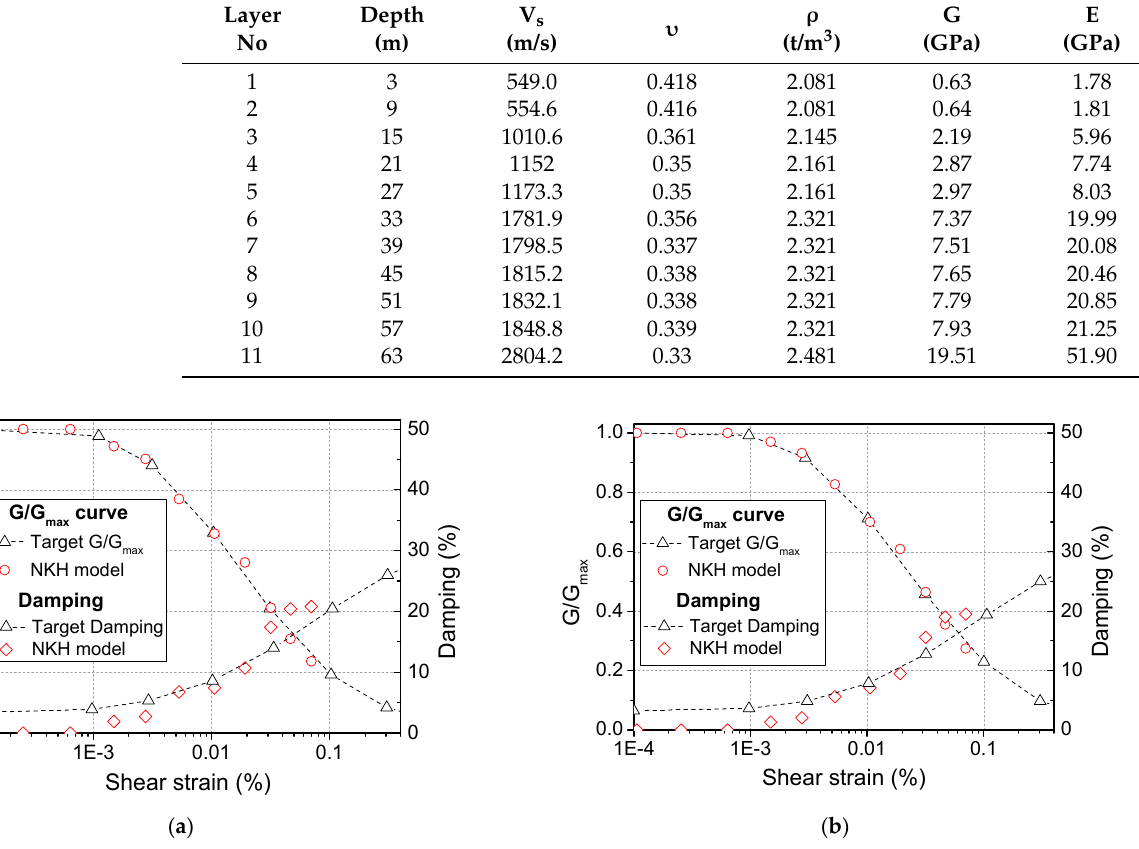
Figure 11. G/G max and damping curves with the NKH model for two rocks in NPP profile: ( a ) layer 3 and ( b ) layer 5. Table 2. Fundamental property profiles for Wolsung NPP.